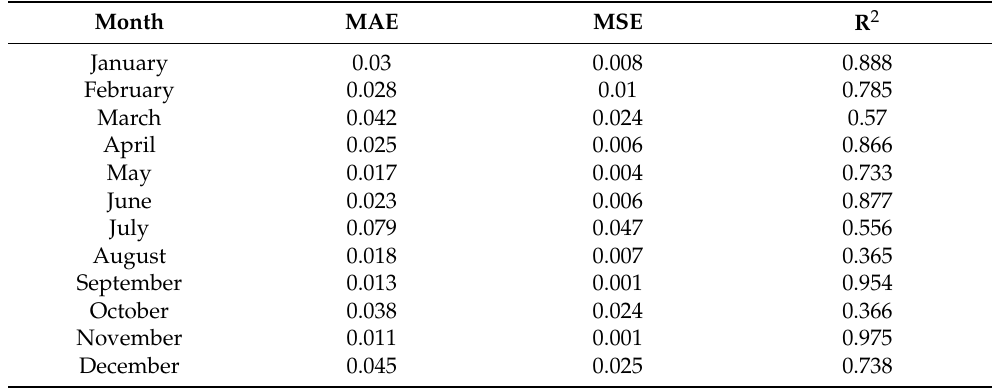
Figure 15. The difference between the actual and predicted value of wind speed over the test set of April, May, and June. Table 3. The performance measures of wind direction prediction over the test set for whole